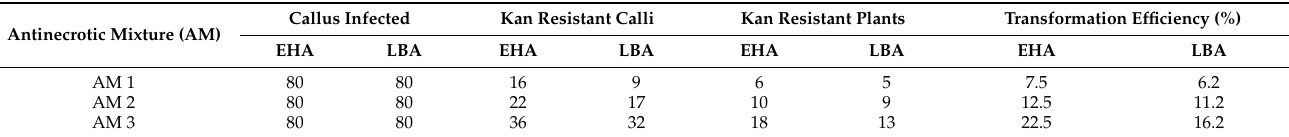
Table A2. Effect of pretreatment with Antinecrotic mix on transformation efficiency of callus derived from seeds of P. scrobiculatum L.